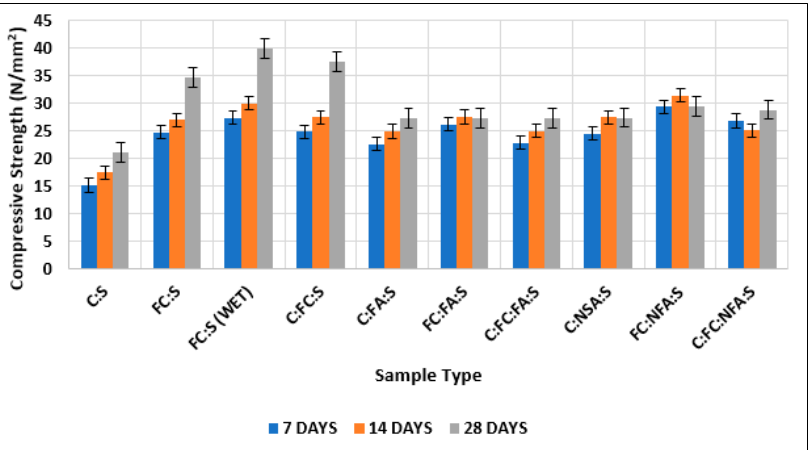
Figure 17. Comparison of test results of cubes with cement and fine cement with test results of cubes with cement, fine cement, and fly ash and with test results of cubes with cement, fine cement, and nano-fly ash.